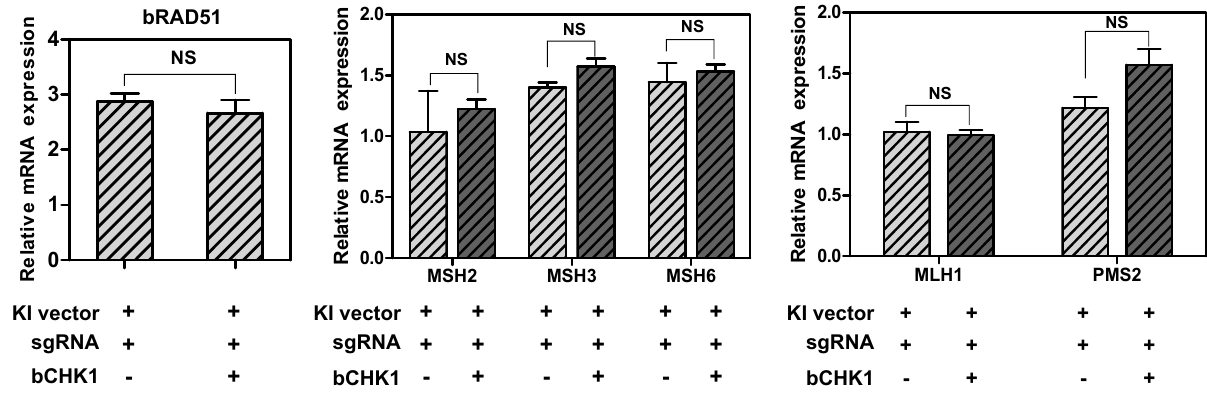
Figure 5. The mRNA levels of CHK1 and DNA MMR-related genes, and CRISPR/Cas9-mediated knock-in efficiency in MAC-T cells induced overex - pression of CHK1 gene. (A) The mRNA levels of CHK1 gene. (B) Polymerase chain reaction analysis of knock-in efficiency. M, DNA size marker (1 kb ladder). (C) The mRNA levels of RAD51 and DNA MMR-related genes. CHK1, Checkpoint kinase 1; MMR, mismatch repair; MAC-T, bovine mam - mary epithelial cells; RAD51, RAD51 recombinase. Error bars show the standard deviation from each sample. NS, no statistical